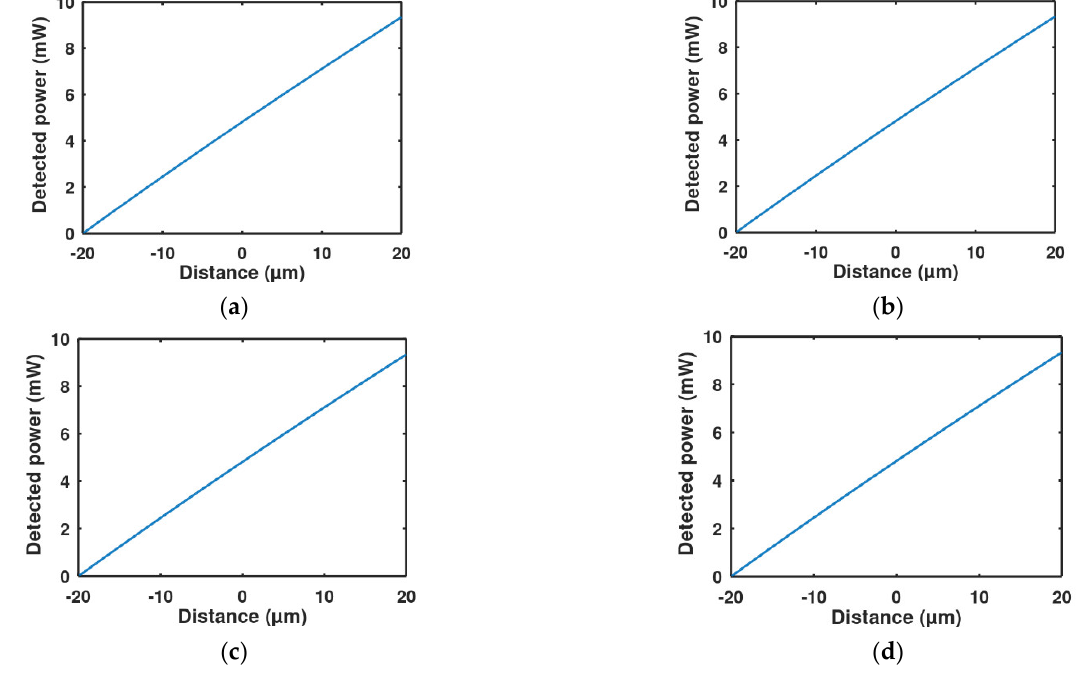
Figure 10. Detected power change with the vertical movement for each quadrant detector: ( a ) The left upper quadrant, ( b ) the right upper quadrant, ( c ) the left lower quadrant, ( d ) the right lower quadrant.